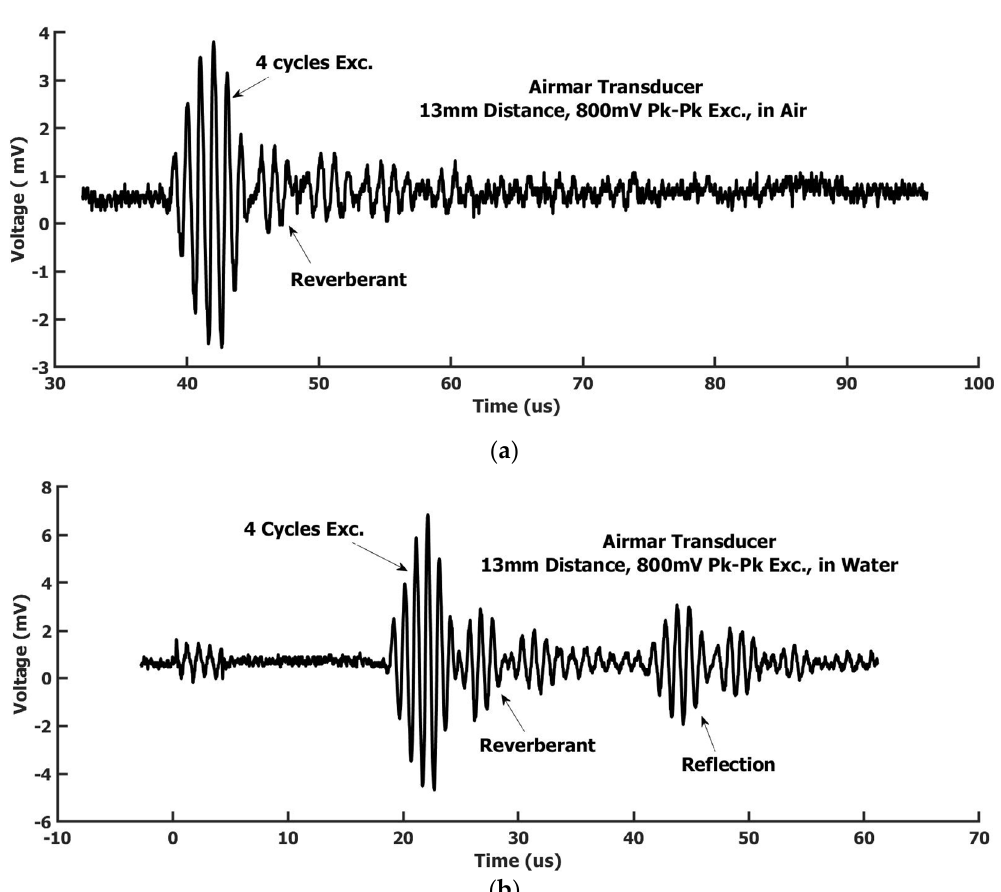
Figure 3. ( a ) The needle hydrophone in air-measured waveform (transmitter: Airmar air-coupled transducer, in air); ( b ) The needle hydrophone in water-measured waveform (transmitter: Airmar air-coupled transducer, in air).